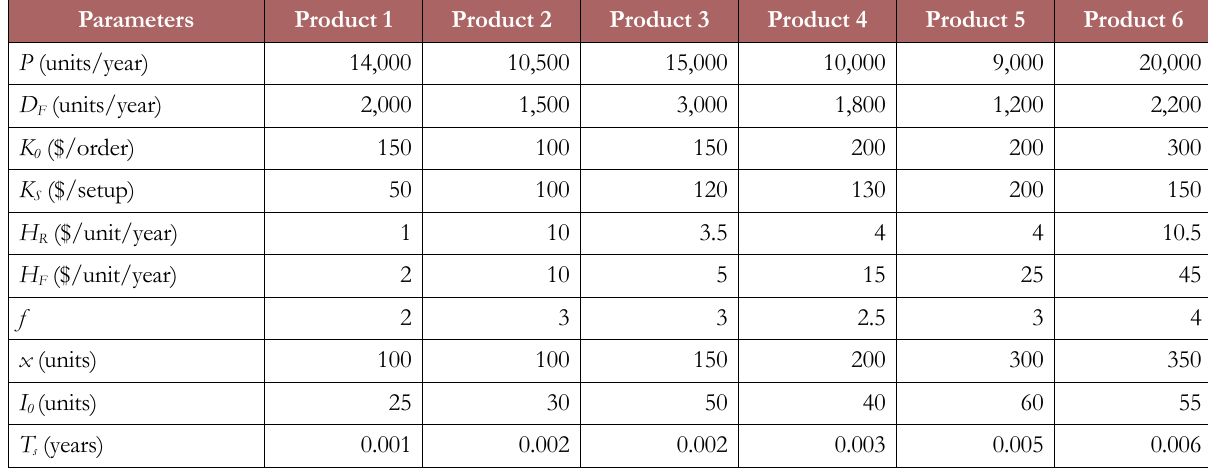
Table 3. Data set for single facility lot-sizing model